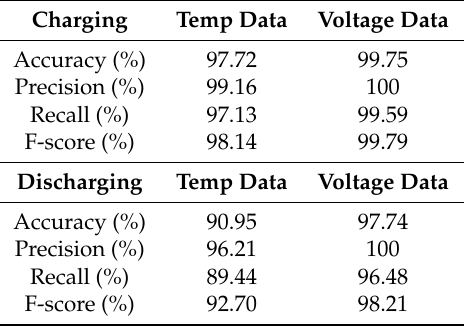
Table 4. Evaluations of binary classification performance (fault and failure-free battery battery set) processed on dimensionally reduced data obtained from charging and discharging